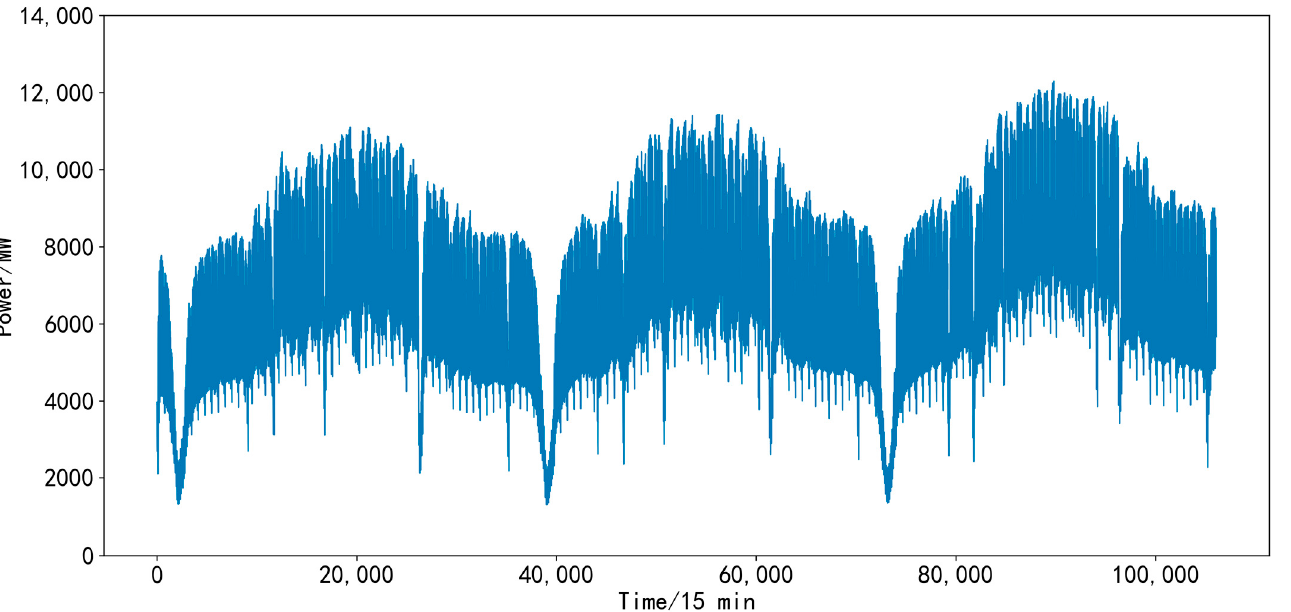
Figure 9. Load trend chart for four consecutive weeks for Area 1. (1)